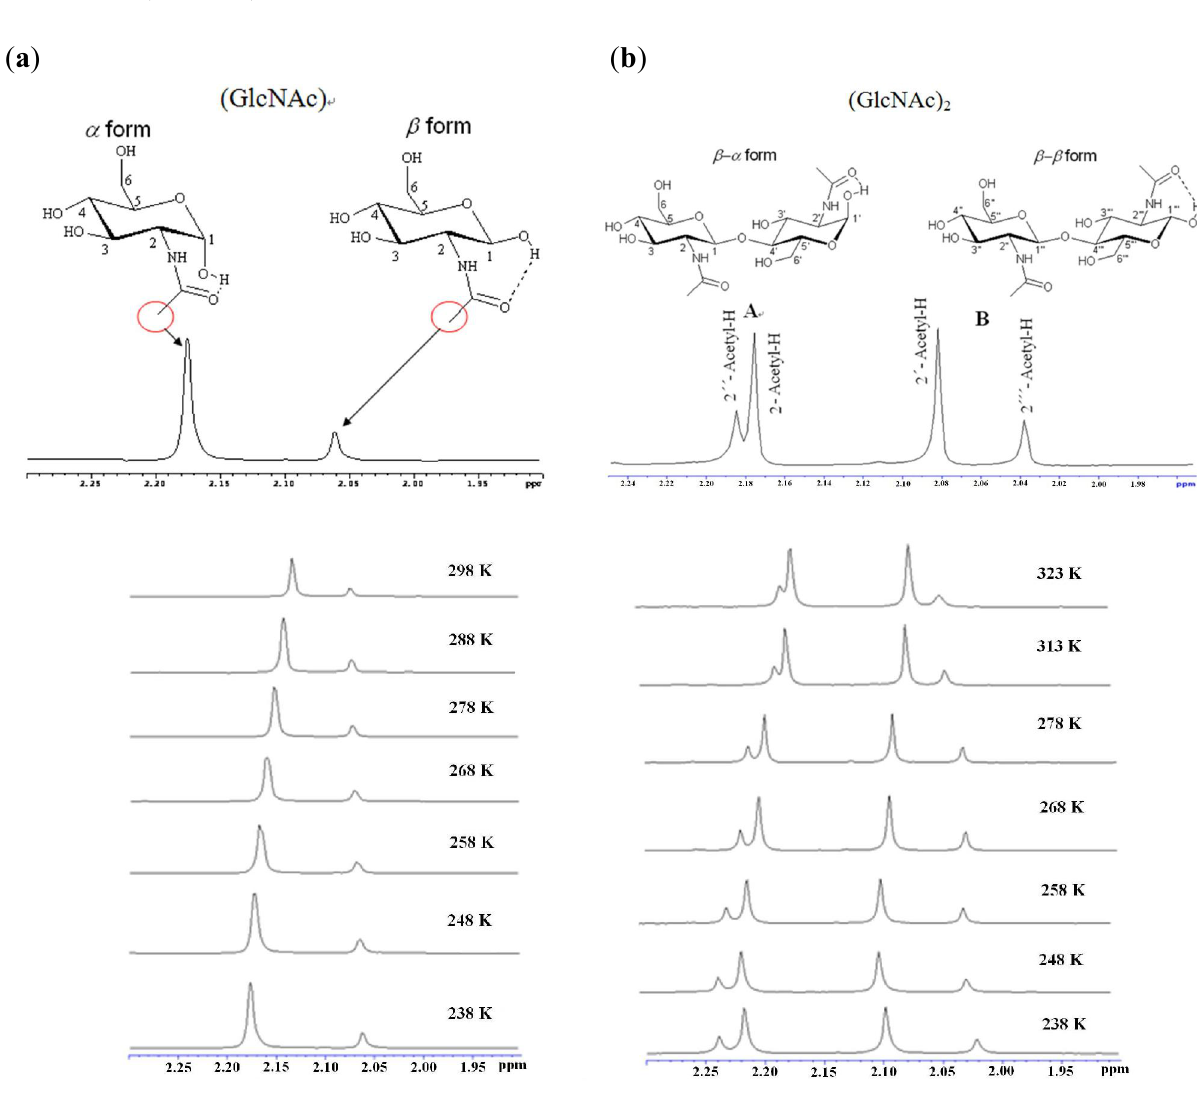
Table 5. The rate constant ( k ) of (GlcNAc) and (GlcNAc)